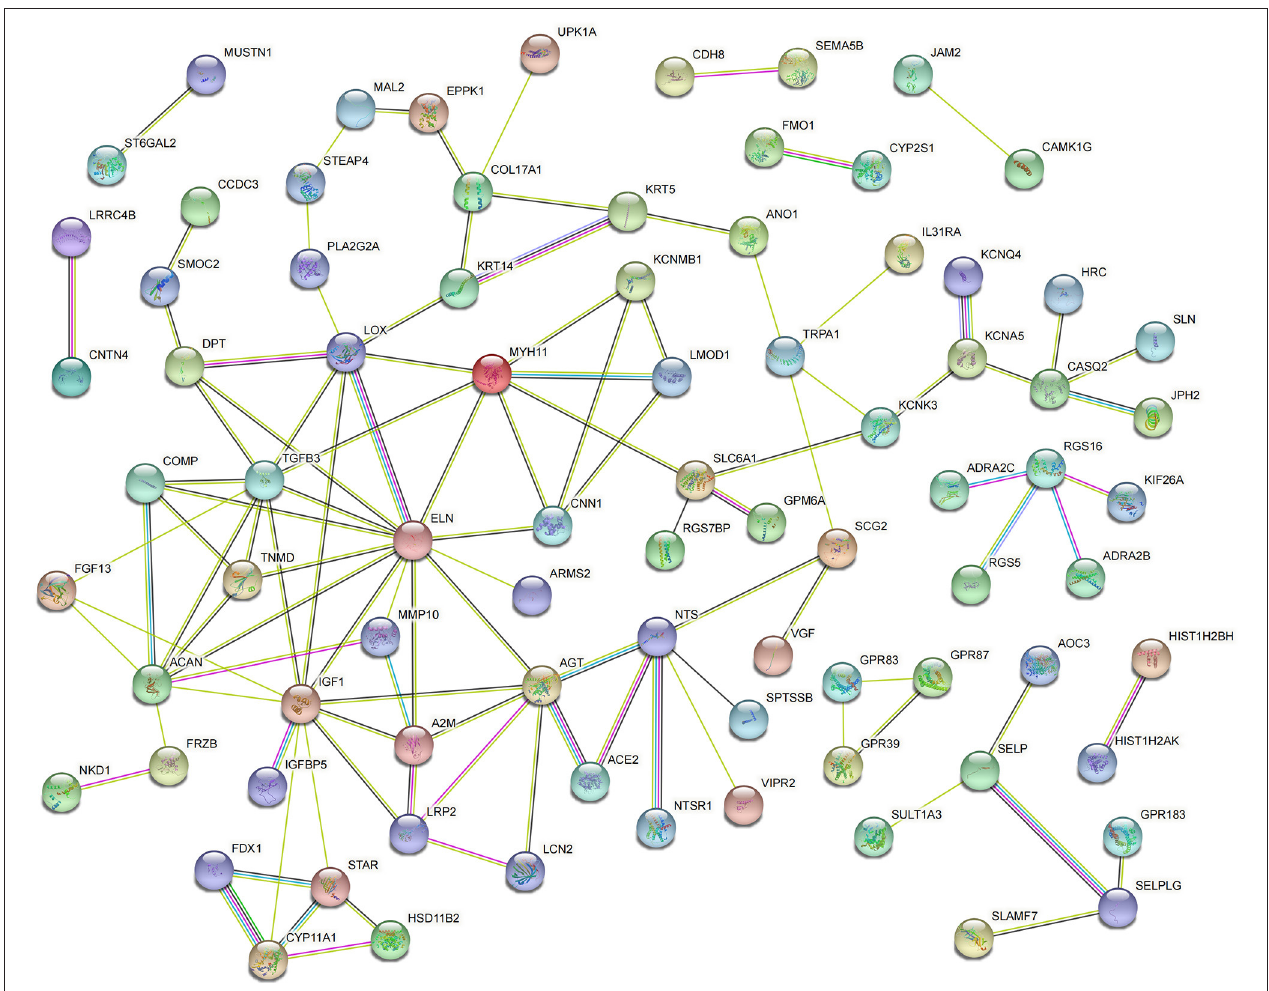
FIGURE 5 | Protein–protein interaction network of DEGs in CPI vs.